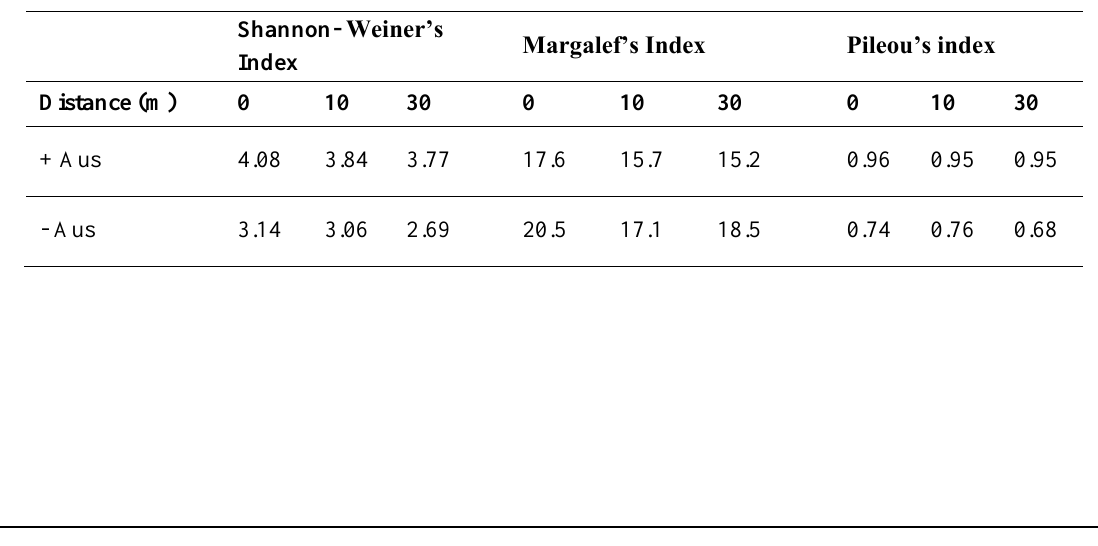
Figure 3: Mean abundance of tree individuals [seedlings < than 0.5 m; saplings < than 2 m and mature > 2 m in height] from the forest-grassland edge (FGE) towards the grassland. Vertical bars represent standard error of the mean (SEM). Table 4: Diversity (Shannon-Weiner’s index), species richness (Margalef’s Index), evenness (Pileou’s index) of standing vegetation (indices calculated with and without Austroeupatorium inulifolium) at 0 m, 10 m and 30 m distances away from the forest grassland edge